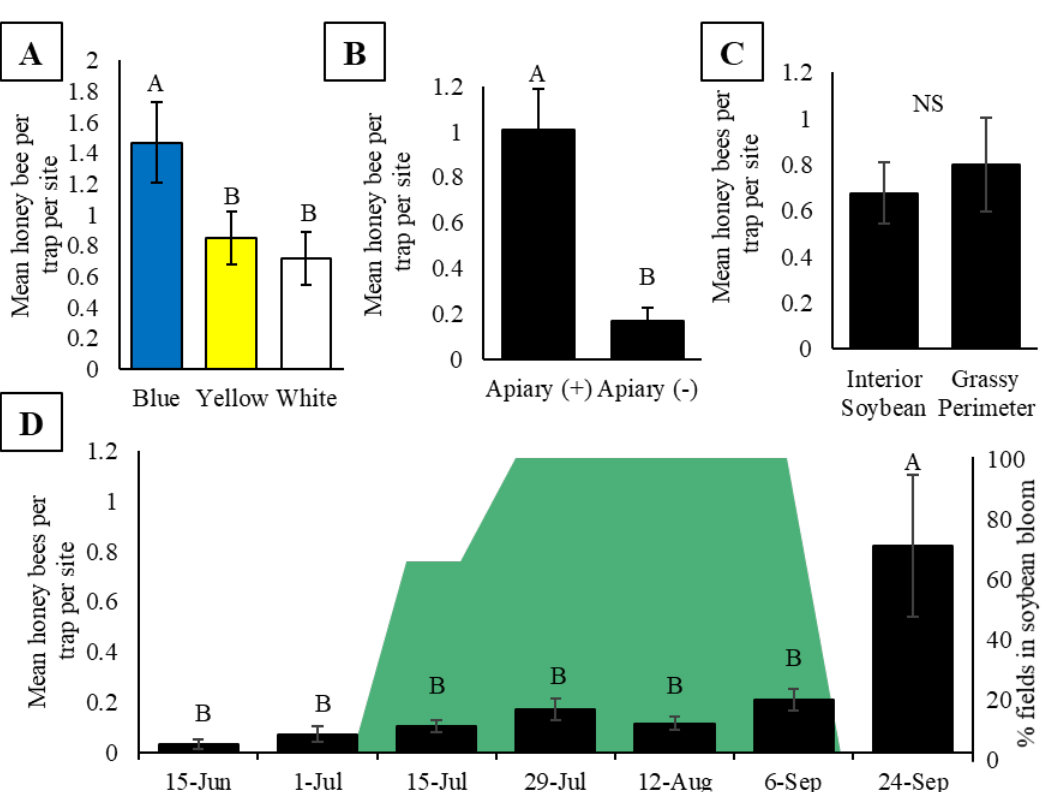
Figure 2. ( A ) Mean honey bee activity-density (bees per trap per site) in pan traps inside soybean fields during 2015 and 2016 in central Iowa. ( B ) Mean honey bee activity-density at Apiary ( + ) soybean fields with pan traps located 10 m inside soybean fields compared to traps placed 10 m into the grassy perimeter of the field during 2016 in central Iowa. ( C ) Mean honey bee activity-density in soybean fields in central Iowa during 2015 and 2016 by trap color. ( D ) Mean seasonal honey bee activity-density inside Apiary ( + ) soybean fields (black bars) during 2015 and 2016. The green block represents the percentage of soybean fields in bloom (R1-R4) at each sampling week. For A-D, activity-density is reported as the mean ± one standard error of honey bees captured in pan traps per site. Different letters signify p < 0.05 for post hoc comparison of least squared means.